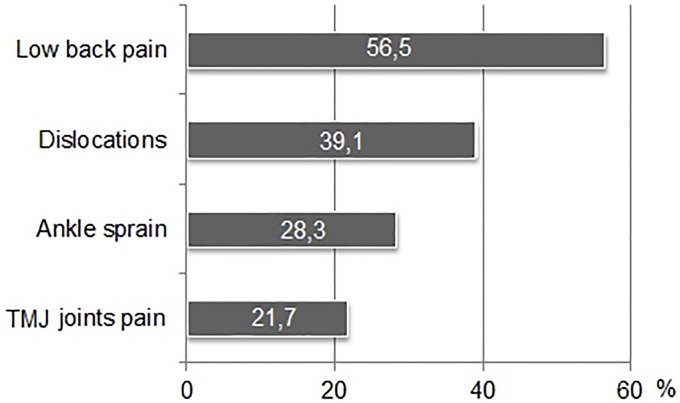
Percentage frequency distribution of the prevalence of JHS symptoms.